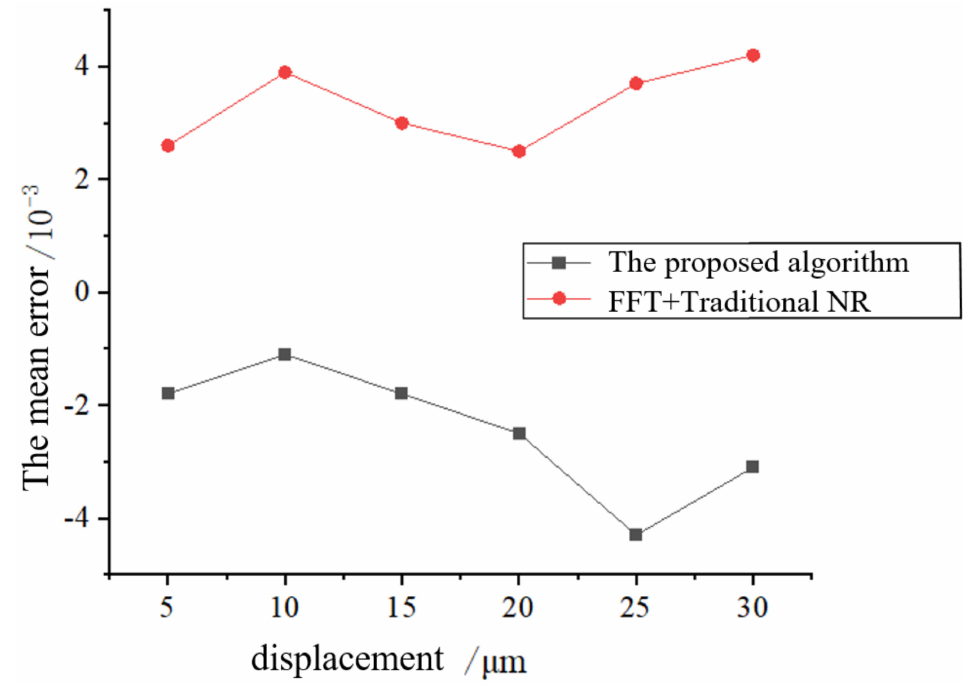
Figure 6. Mean error of different displacements.